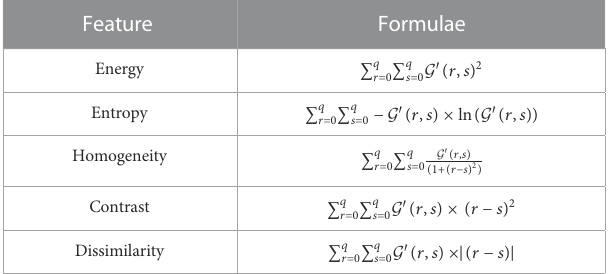
TABLE 4 Features extracted from a co-occurrence matrix G of DNA sequence S